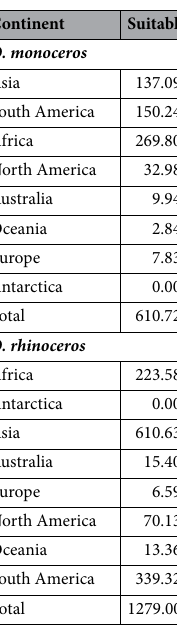
Table 4. The suitable area (ten thousand km 2 ) of O. monoceros and O. rhinoceros by continent.